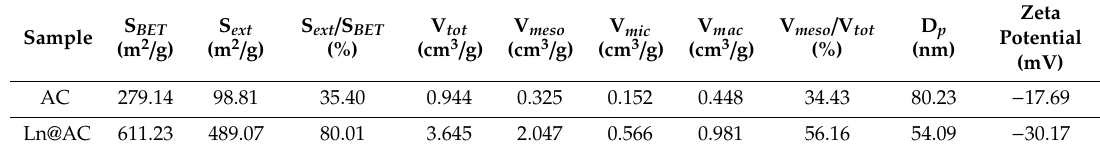
Table 1. Pore structure parameters and zeta potential of lignocellulose@ activated clay (Ln@AC) studied in this